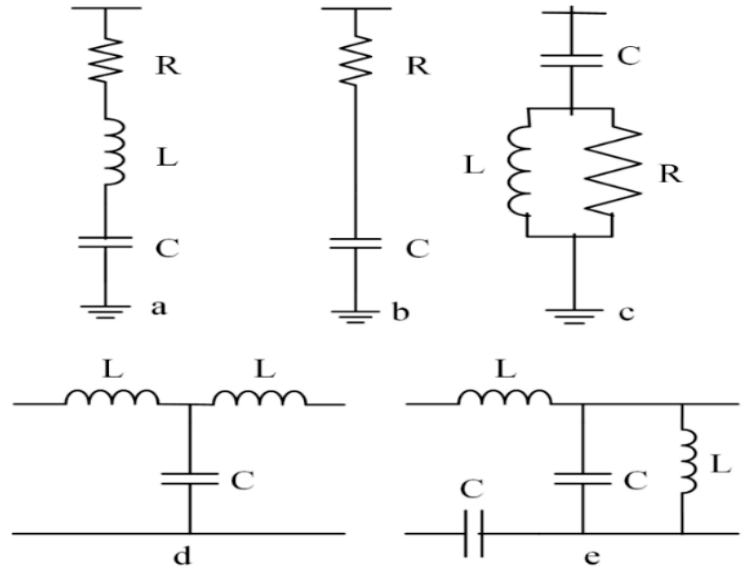
Figure 1. PF structures: ( a ) single-tuned; ( b ) first-order high-pass; ( c ) second-order high-pass; ( d ) LCL; and ( e ) LLCC filters.